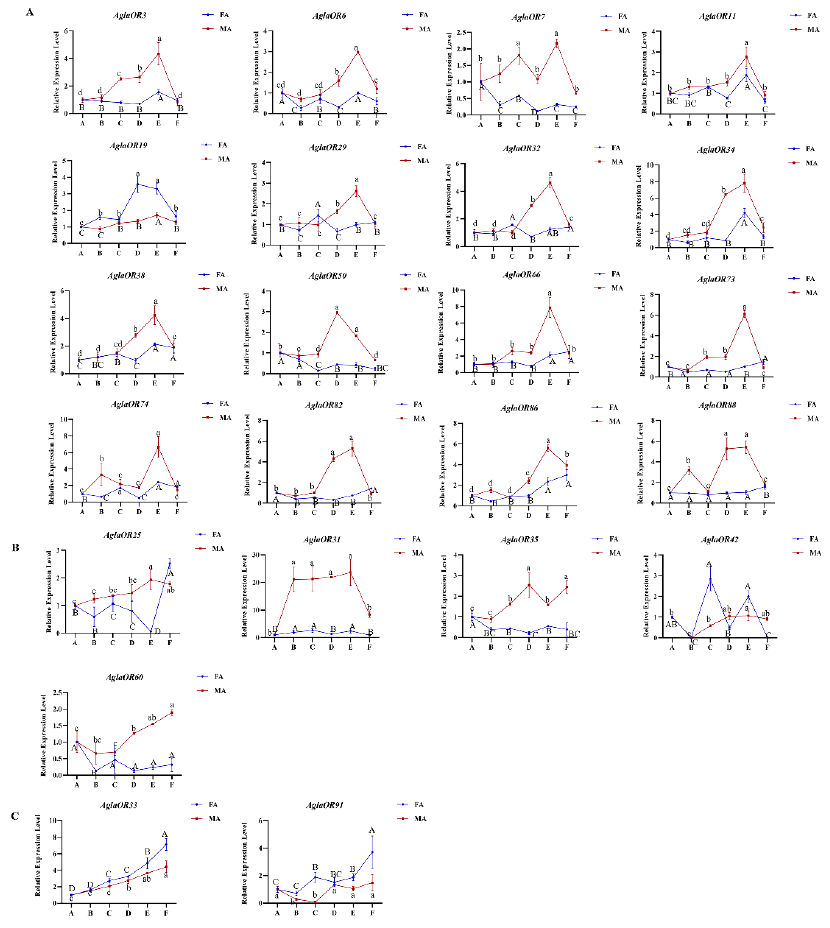
Figure 5. The expression levels of AglaORs at different stages of adult development were analyzed by RT-qPCR. A, eclosed in the pupal chamber; B, eclosed; C, received supplemental nutrition for 1 d; D, received supplemental nutrition for 7 d; E, received supplemental nutrition for 12 d; and F, post-mating. Actin was used as a housekeeping gene to normalize the expression level of each treatment. The gene expression of A (eclosion in pupal chamber) was used as the control. The relative expression level is expressed as the standard error (SEM) of the mean value. The lowercase letters above the bar indicate significant differences in FA expression at different developmental stages, and the uppercase letters indicate significant differences in MA expression at different developmental states ( p < 0.05, LSD). Subfigure ( A ) represents the genes with significant high expression in sexual maturity, ( B ) represents the genes with no significant difference expression in each development stage, and ( C ) represents the genes with significant high expression after female post-mating grooving phase.